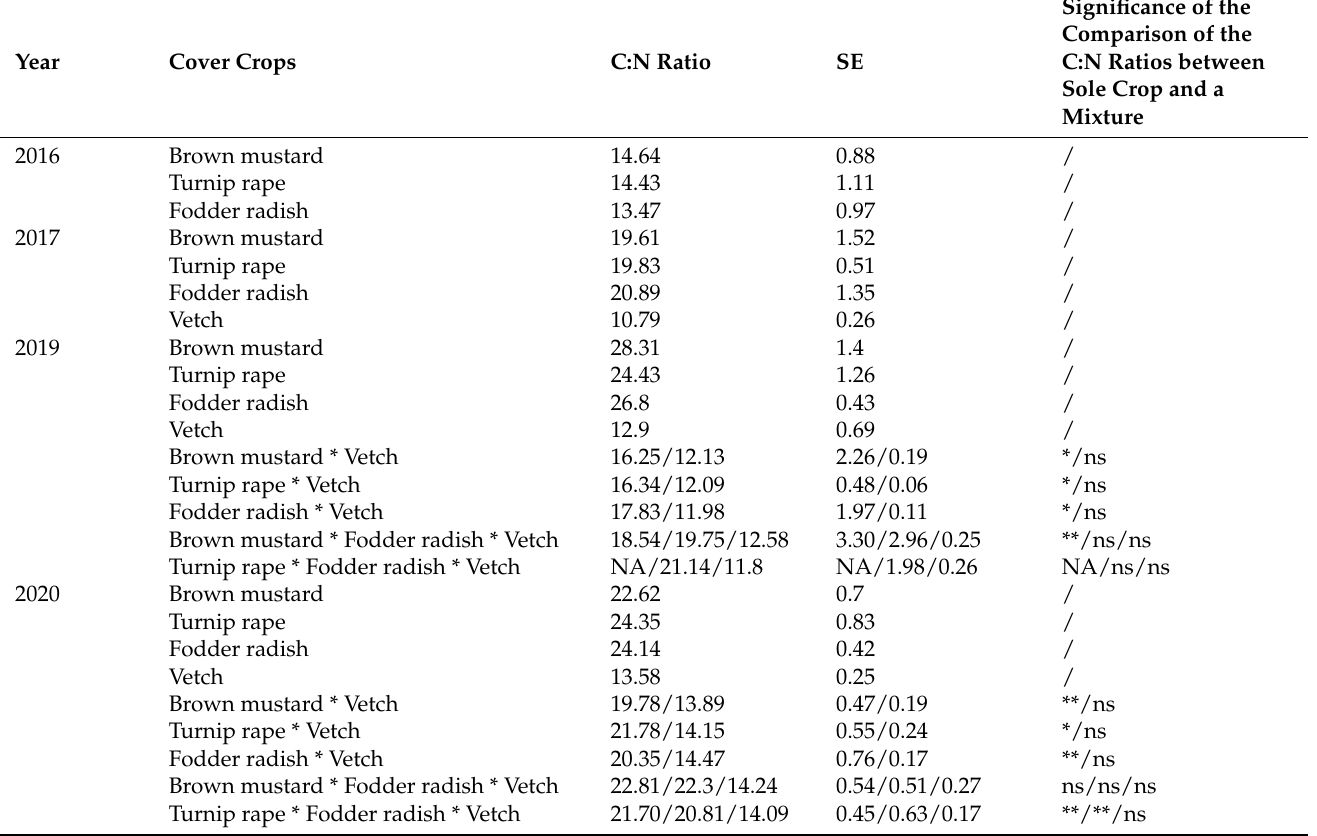
Table A2. C:N ratios of each cover crops species in sole crops and in a mixture of two or three species calculated from C and N contents at the destruction of the cover crop, in 2016, 2017, 2019 and 2020. SE represents the standard error. Abbreviations ns, *, **, indicate non-significant, or significant differences at p < 0.05 or p < 0.01, respectively. NA indicate non applicable (no data available to test this interaction).